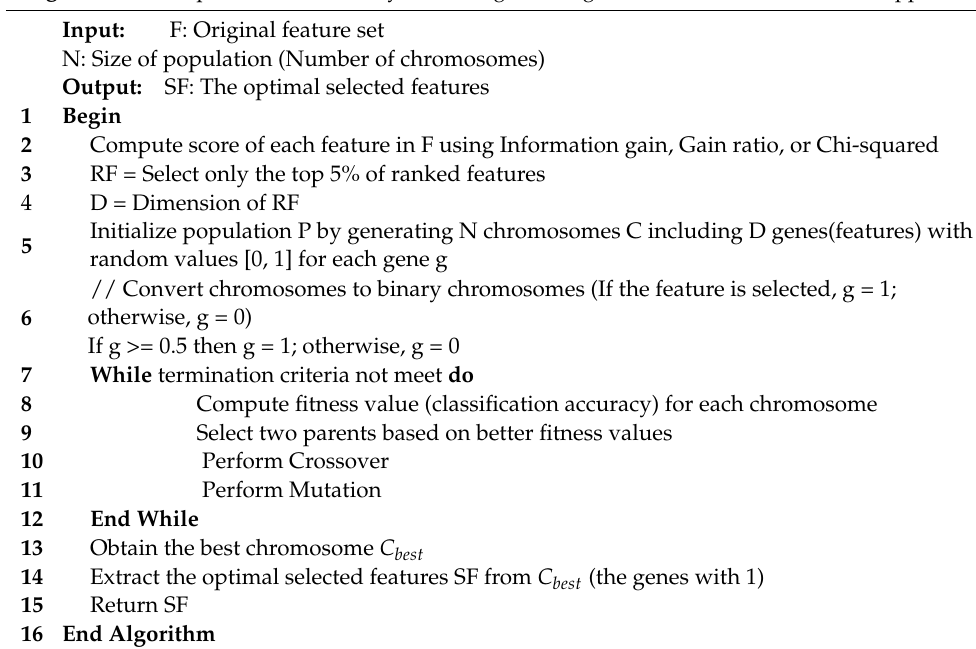
Algorithm 1 : The pseudocode of the hybrid filter genetic algorithm-based feature selection